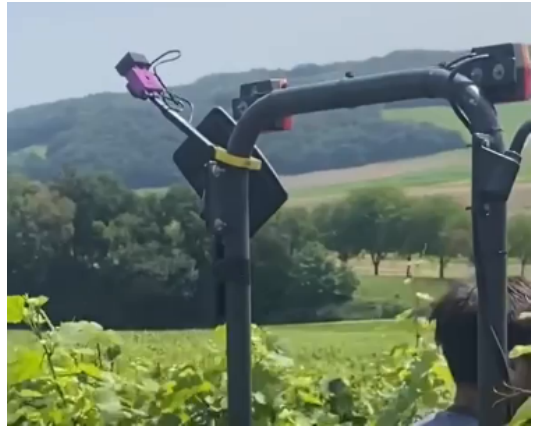
Figure 2: Sensor mounted on a tractor using a 3D printed adapter. 7 viewpoints, located on two lines at two different distances from the calibration site. From each of the positions, 4 views have been shot by varying the orientation of the camera (Figure 3), resulting in 28 views (each composed of 1 RGB image and 4 mono-band images).